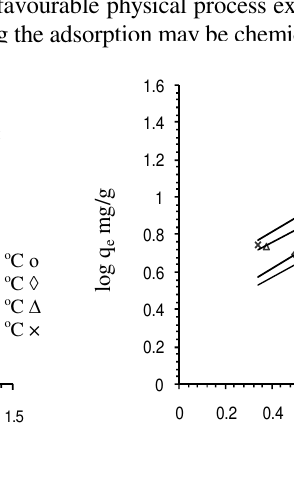
Figure 6. Freundlich isotherm for the adsorption of Cr(VI) onto MPGP at different temperature. Table 1 . Comparison of the coefficients isotherm parameters from chromium (10, 20, 30, 40 mg/L) adsorption onto MPGP .